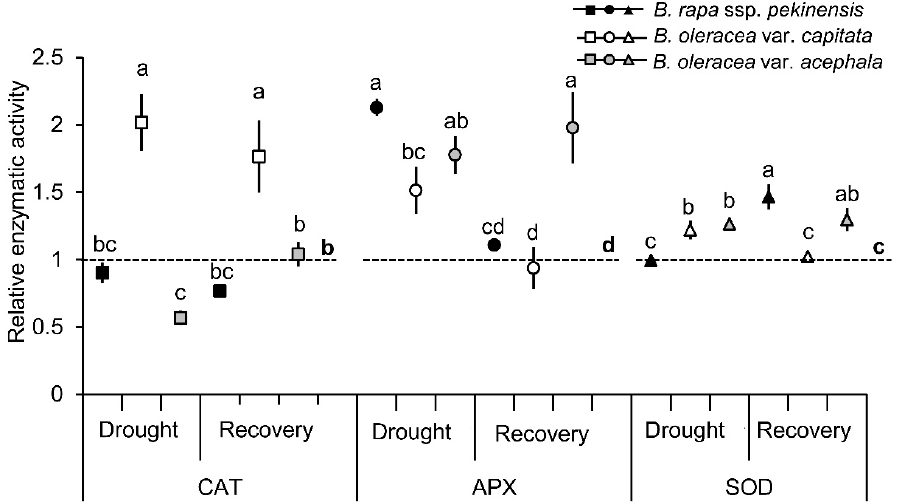
Figure 4. Antioxidant enzyme assays: catalase (CAT), ascorbate peroxidase (APX) and superoxide dismutase (SOD) in leaves of Brassica crops under drought period and following recovery. Controls are normalized to the value 1 (broken line). The bars are mean ± SD, n = 4. Points marked with different letters differ significantly at p < 0.05. Raw data are presented in Supplementary Table